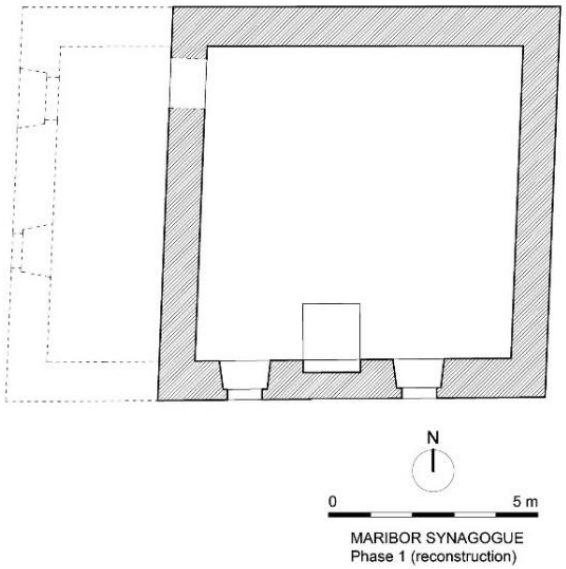
Figure 14. Ground plan of the first synagogue phase. Architectural drawing: Nejc Bernik, based on a template by Anja Premk.